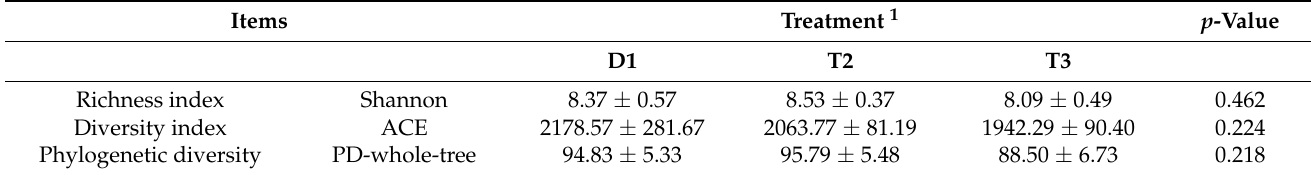
Table 7. The effects of RPLys and RPMet on the alpha diversity analysis index of Holstein bulls.